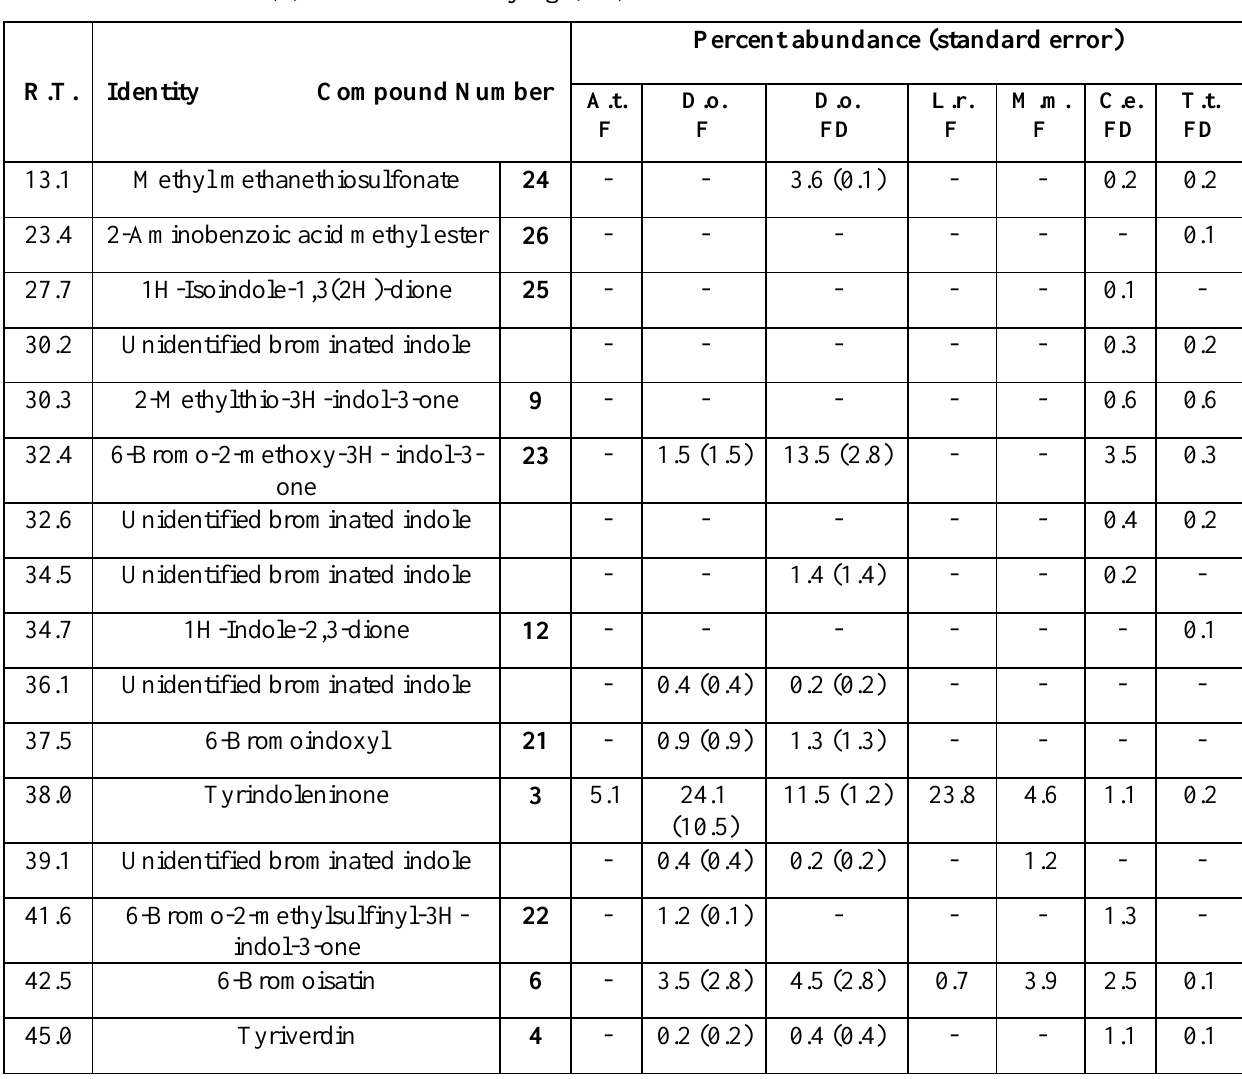
Table 1 . Volatile indole derivatives found in the egg masses of six muricid molluscs using gas chromatography/ mass spectrometry. R.T. refers to the retention time in the gas chromatograph (GC). The percent abundance of each compound is calculated from the total relative intensities of all volatile compounds found in each extract (presented as a mean with standard error where duplicate samples were examined). The extracts from four Australian species, Agnewia tritoniformis (A.t.), Dicathais orbita (D.o.), Lepsiella reticularis (L.r.), Morula marginalba (M.m.), as well as two Mediterranean muricids Ceratostoma erinaceum (C.e.) and Trunculariopsis trunculus were examined. The eggs were either extracted fresh (F) or after freeze drying